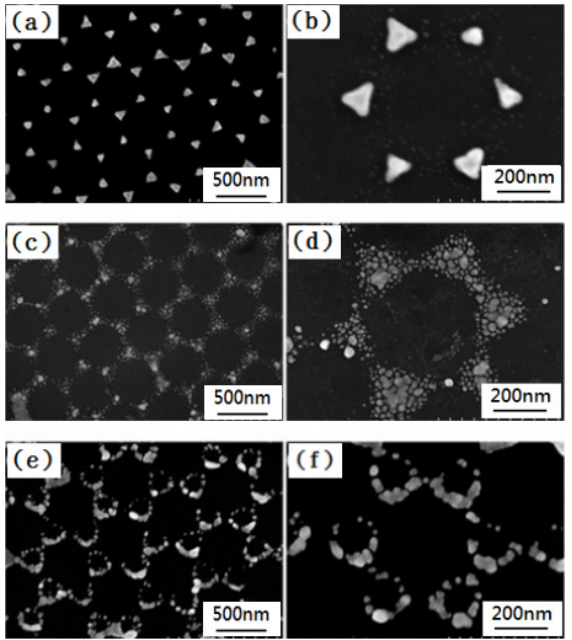
Figure 9. SEM images of two-dimensional ordered Au-Ag nanoparticles arrays fabricated by different physical vapor deposition methods. ( a , b ) Thermal evaporation; ( c , d ) RF magnetron sputtering; ( e , f ) e-gun deposition.